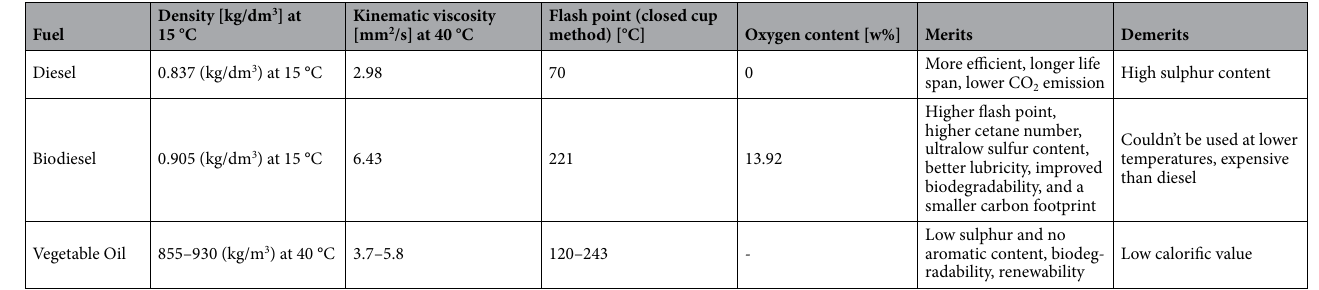
Table 1. Comparison of physicochemical properties, merits and demerits of biofuels and conventional fuel 3,4 .